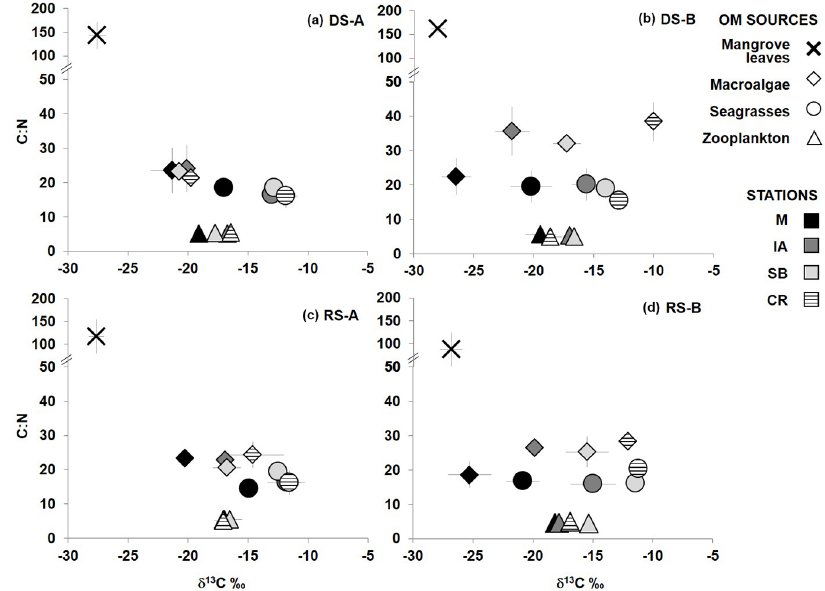
Figure 2. C:N ratio versus δ 13 C (‰) of organic matter sources from the four sampling stations (mangrove forest M in black, intertidal area IA in dark grey, seagrass bed SB in light grey, coral reef CR in stripes) along transects A and B in dry (DS) and rainy seasons (RS). Mangroves (cross), macroalgae (diamond), seagrasses (circle) and zooplankton